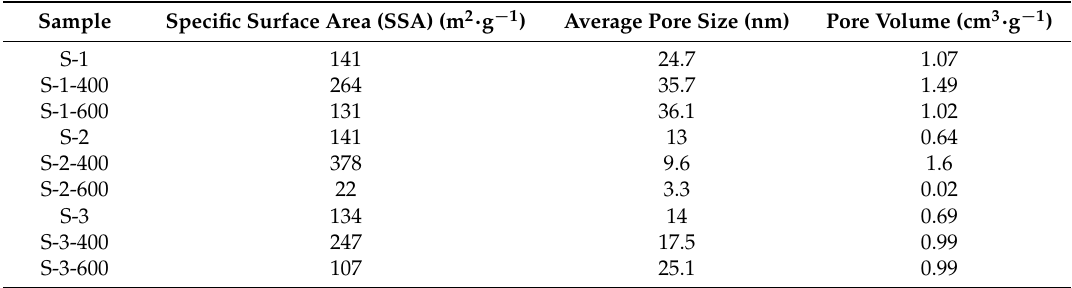
Figure 7. N 2 adsorption–desorption isotherms and pore-size distributions of silica aerogels: ( a ) S-1, ( b ) S-2 and ( c ) S-3 before and after heat treatment at 400 °C and 600 °C, respectively. Table 1. Pore structures of silica aerogels prepared with various surfactants before and after heat treatment at 400 °C and 600 °C, respectively.